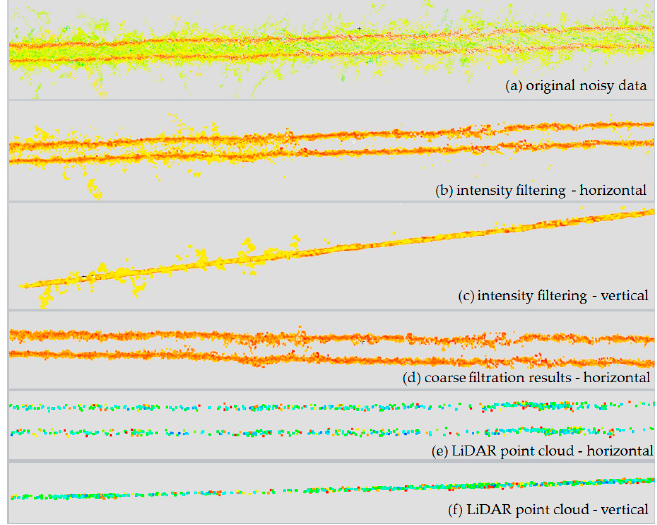
Figure 11. Results of different stages of coarse filtration: ( a ) original points, ( b ) intensity filtration – horizontal view, ( c ) intensity filtration – horizontal view, ( d ) result of filtering with intensity and geometric condition – horizontal view, ( e ), ( f ) – LiDAR point clouds – horizontal and vertical view.